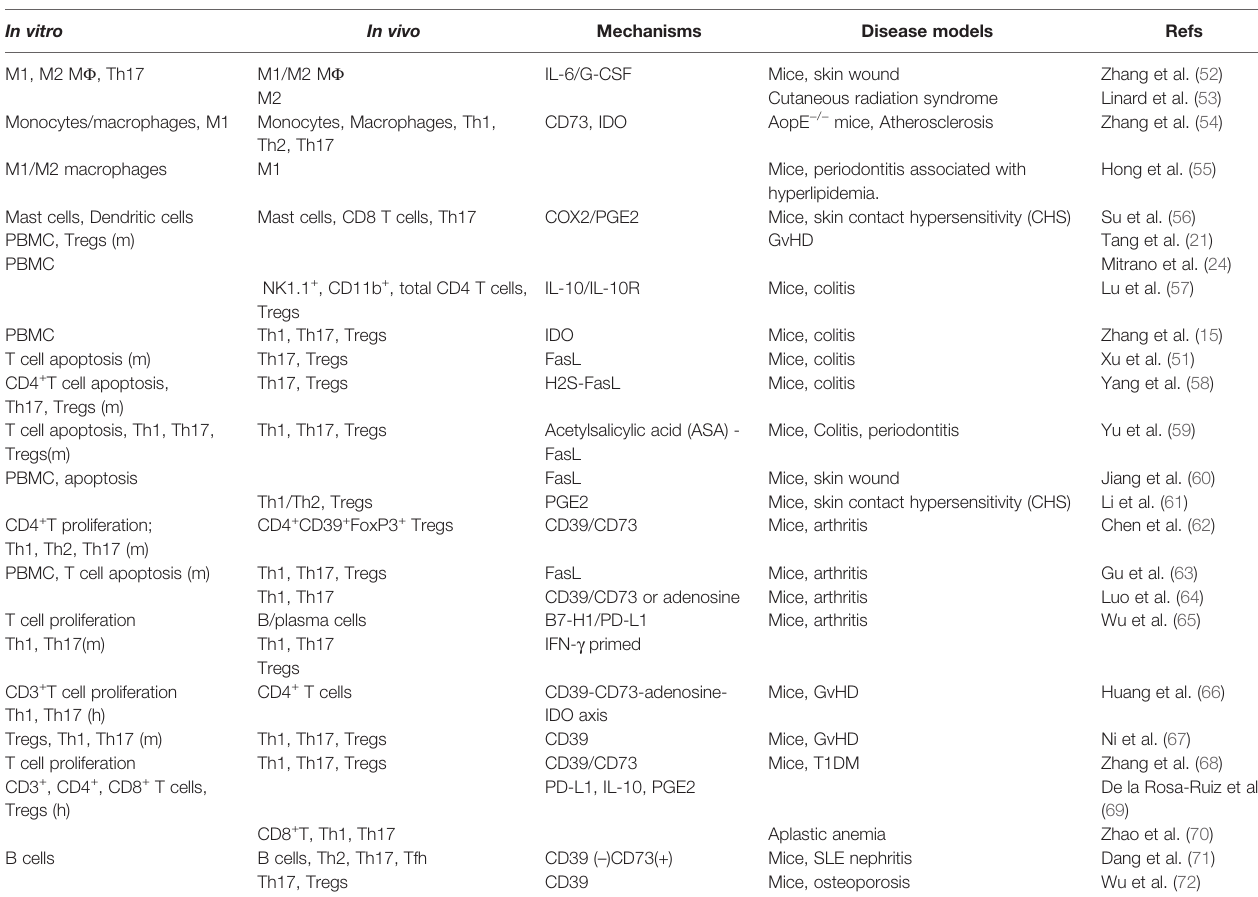
TABLE 2 | Immunomodulation of GMSCs. In vitro In